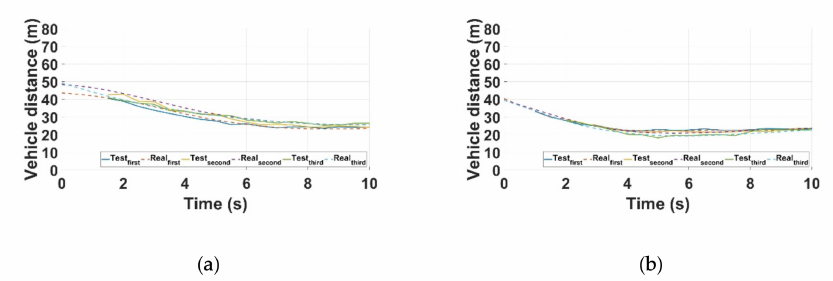
Figure 18. Comparison of theoretical values and real vehicle test results based on distance to the lead vehicle: ( a ) scenario 9 and ( b ) scenario 10.